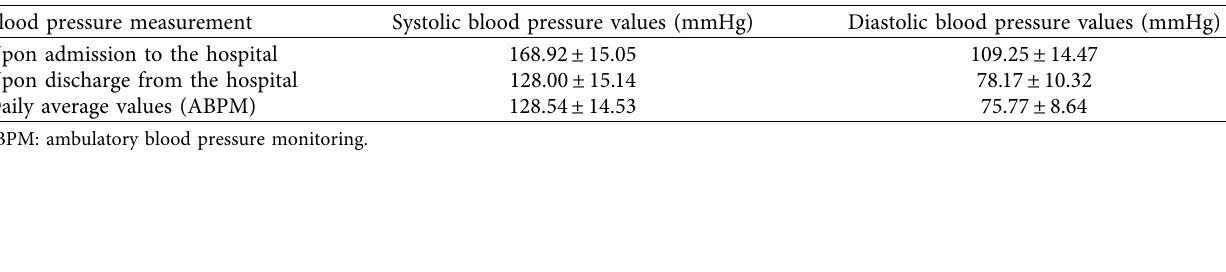
Table 4: Hypertensive drugs used by the patients admitted to the hospital due to hypertension ( n � 204). Hypertensive drugs